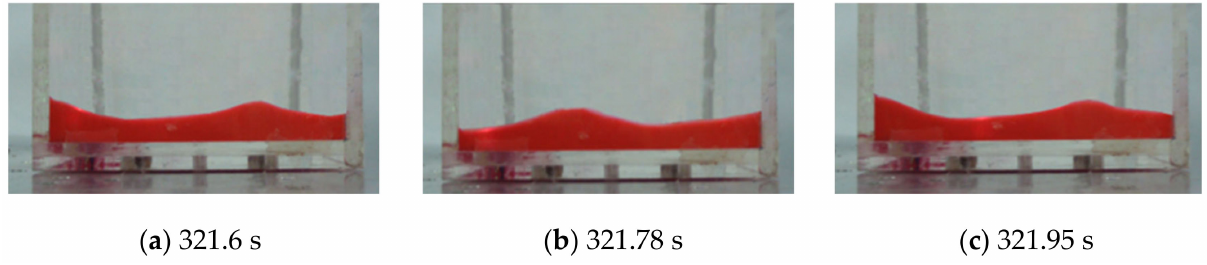
Figure 18. Still shots of a third natural frequency wave recorded by the video